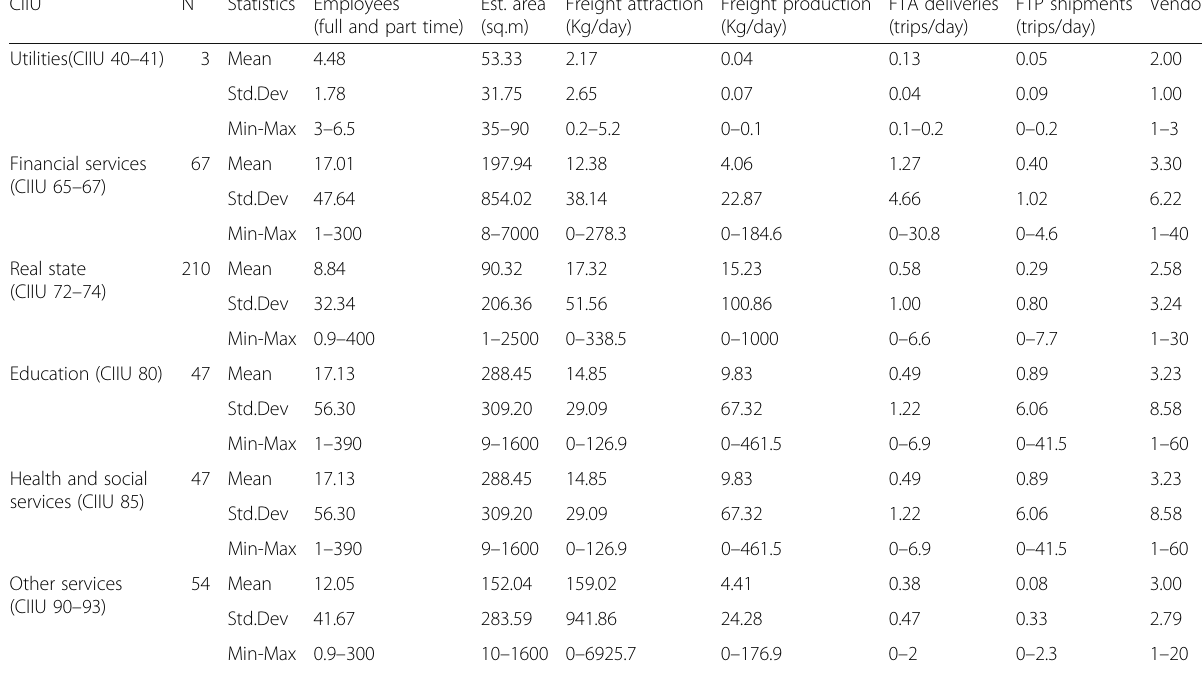
Table 6 Statistics of non-freight intensive sector (service-oriented) commercial establishments CIIU N Statistics Employees Est. area (full and part time)